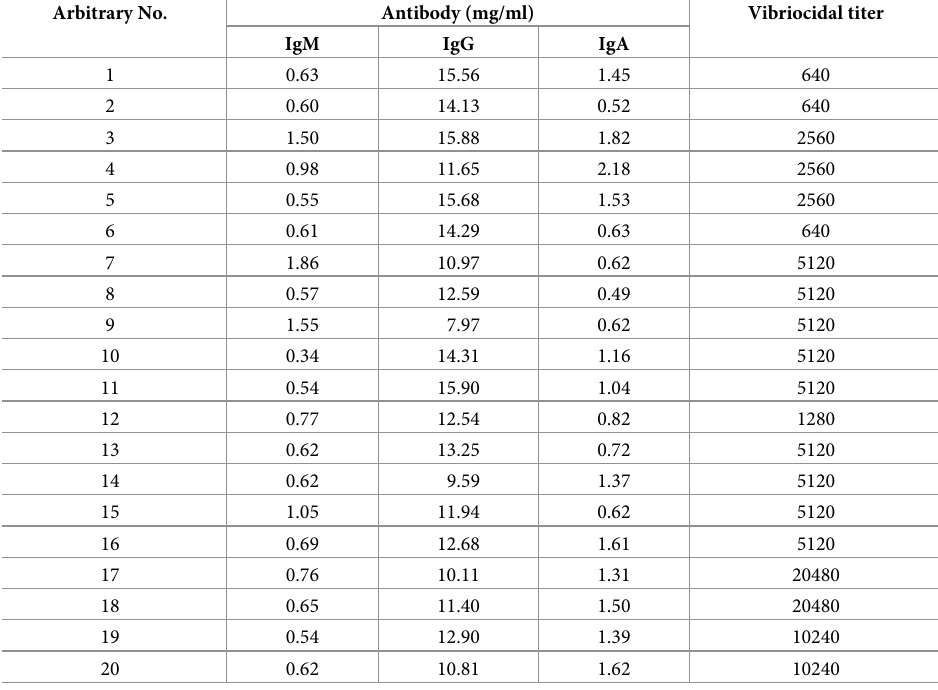
Table 1. Total amount of antibodies and vibriocidal titers in the clinical sera. Arbitrary